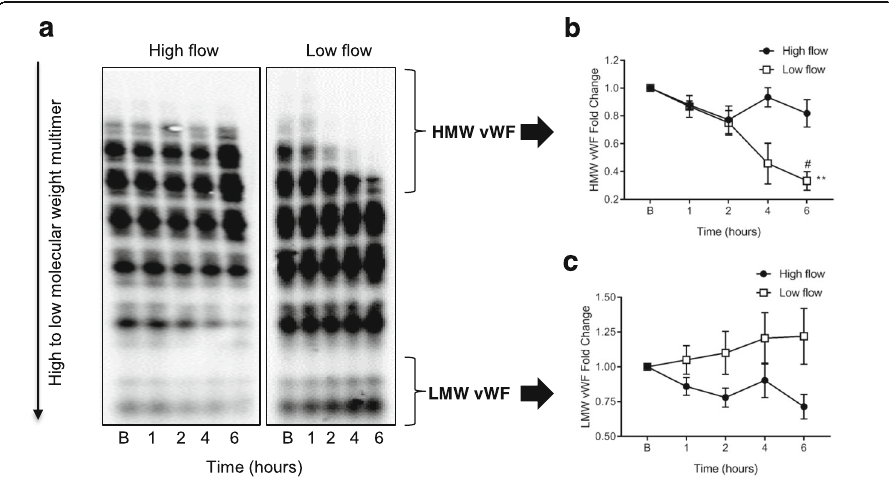
Fig. 4 Measurement of von Willebrand factor (vWF) multimers by immunoblotting in whole blood subjected to high and low flow conditions. Representative immunoblot image from two gels run at high flow and low flow ( a ) with loss of high-molecular-weight (HMW) vWF bands (analysed by densitometry). Data normalized to total vWF for HMW multimers ( b ) and LMW multimers ( c ). Data are presented as mean ± SEM. ** p < 0.01 from baseline to 6 h; # p < 0.05 high vs low flow. n = 5 high flow, n = 4 low